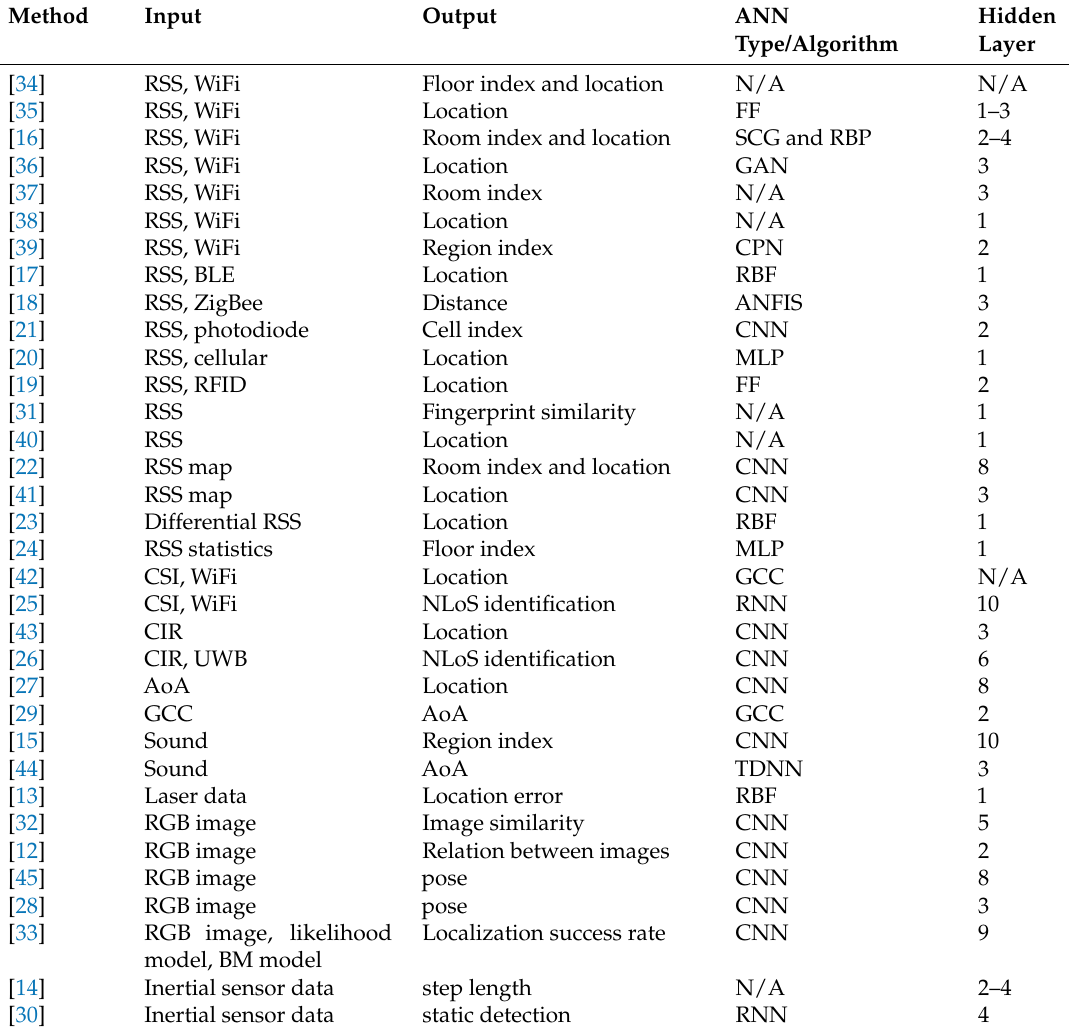
Table 1. Part of existing works that use ANN to improve localization (within the year of 2018).